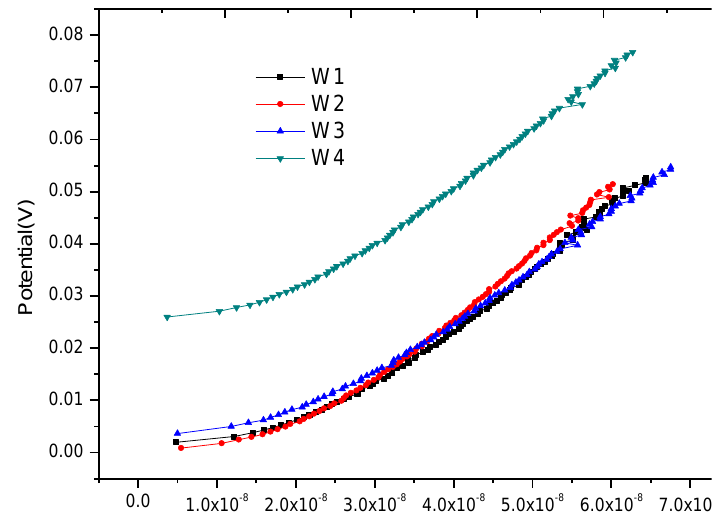
Figure 11. Anodic polarization curve for each monitoring point after drying for one month.